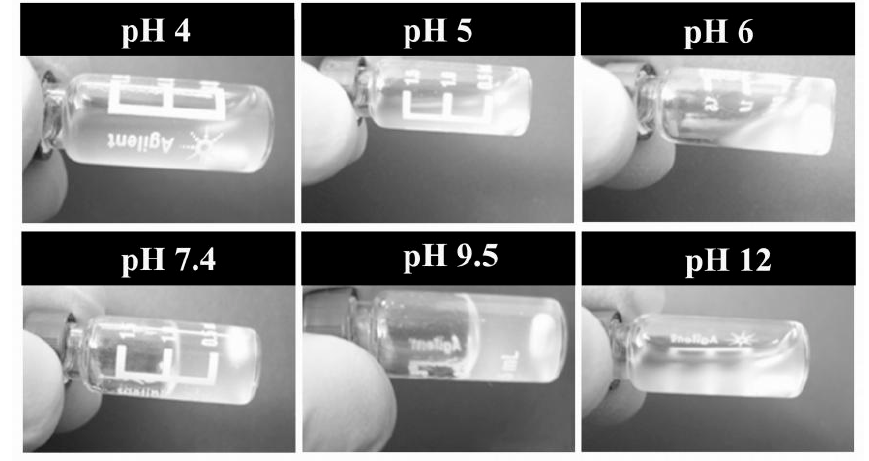
Figure 6. Digital images of P(AA- co -VAm) microgels at varied pH. The concentration of microgels is 2.5 wt %.